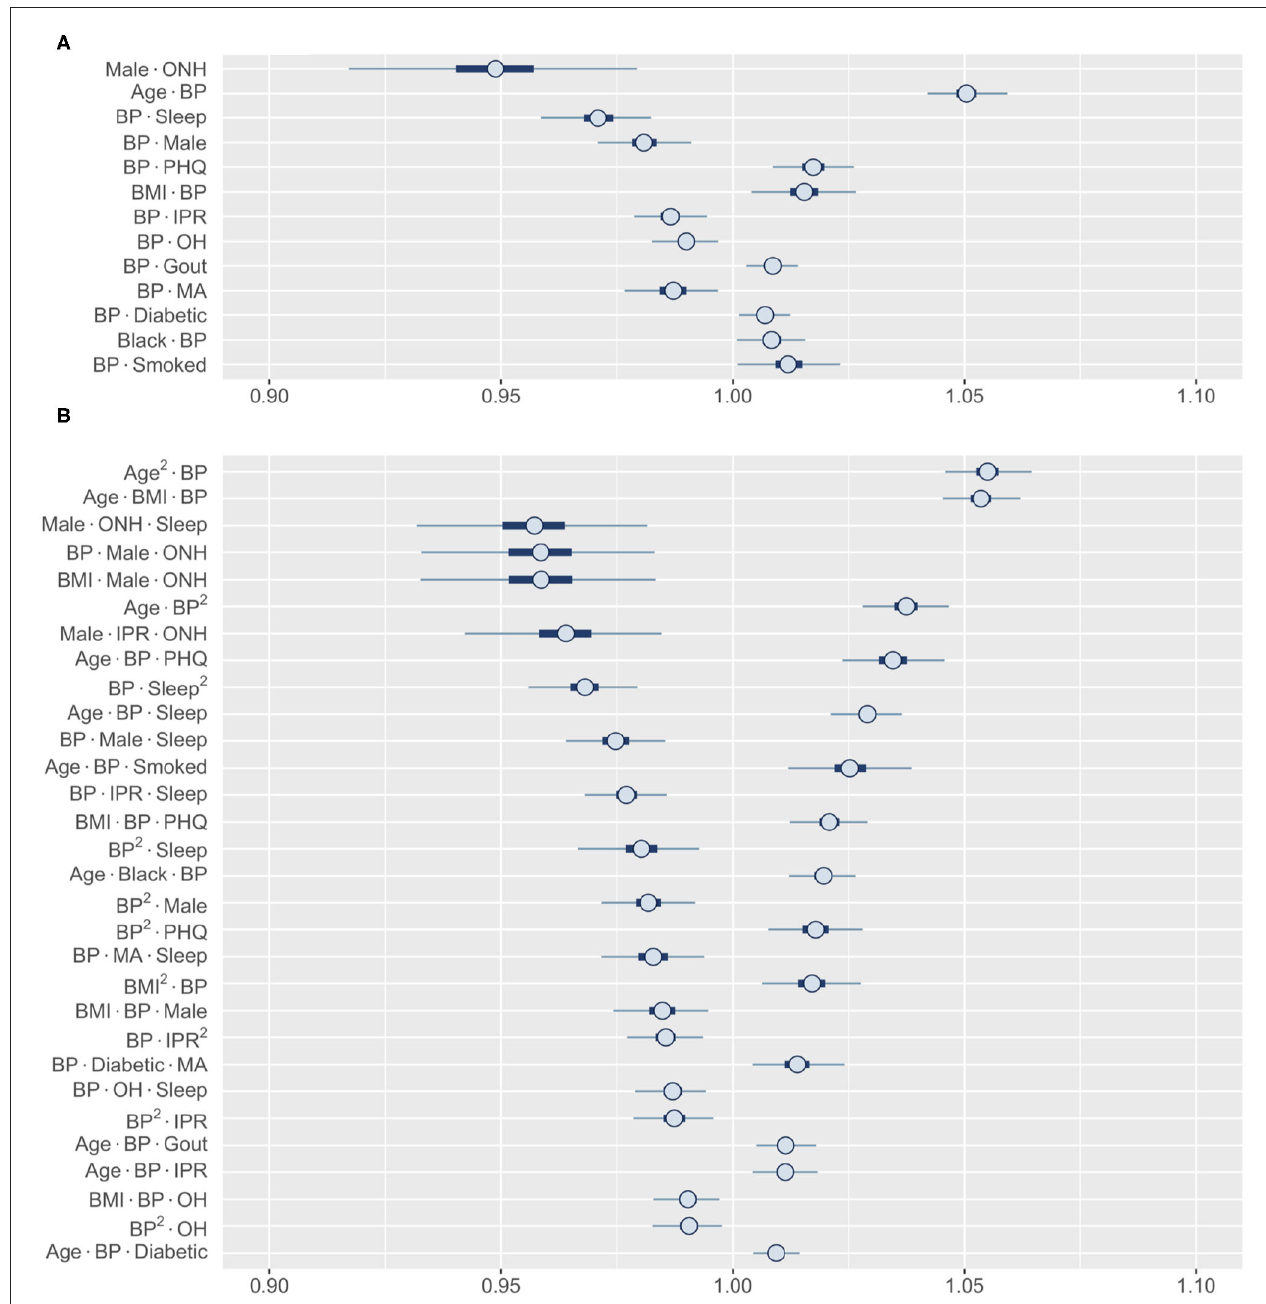
FIGURE 7 | Posterior distributions of most relevant interactions that include either BP or ONH ethnicity as one risk factor. (A) 13 most influential second-order interactions and (B) 30 most influential third-order interactions are shown. Inner bounds represent 50% HDIs and outer bounds represent 99% HDIs. Standardized coefficient estimates are shown. MA, Mexican-American; OH, Other Hispanic; ONH, Other Non-Hispanic. Horizontal scale shows odds multipliers for risk of RA for a one standard deviation increase in value of variable.